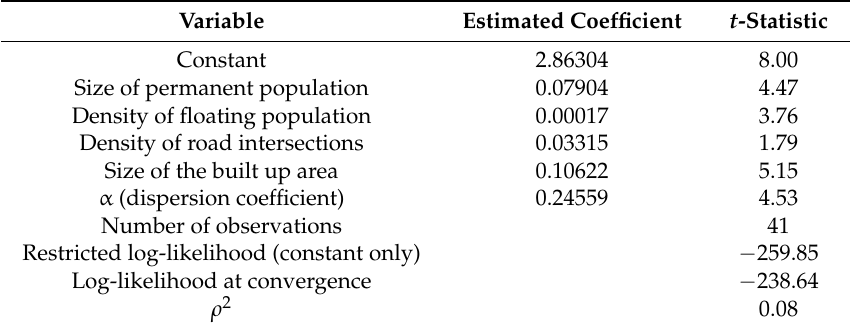
Table 1. Negative binomial estimation results of non-motor vehicle